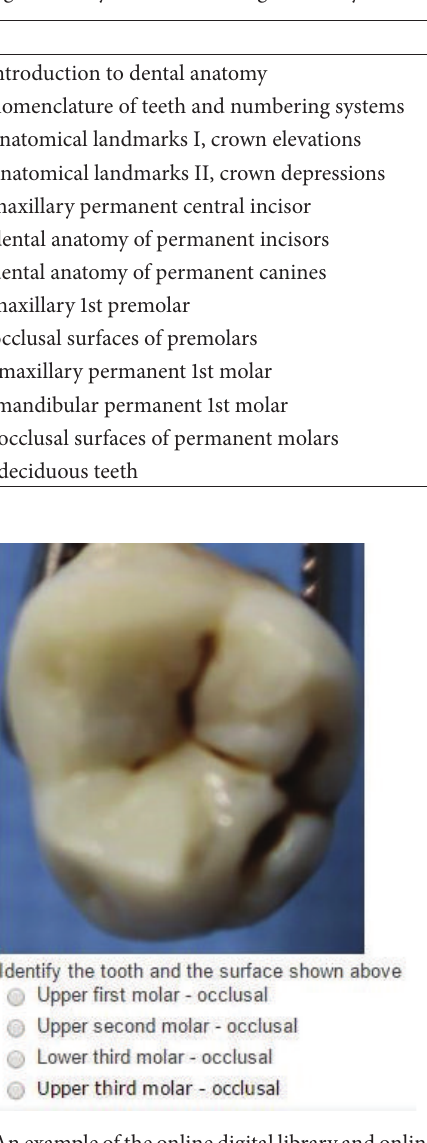
Table 1: The semester map for the dental anatomy course which includes the timing and order of didactic lectures, practical laboratory sessions augmented by online videos/digital library, and assessment items.